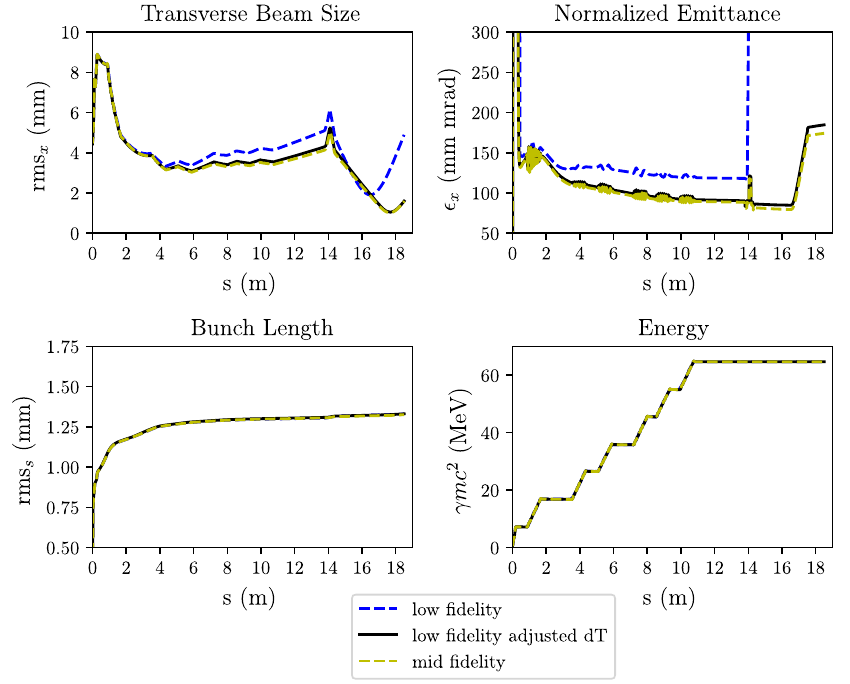
FIG. 7. Comparison of different fidelity models ( dT stands for time